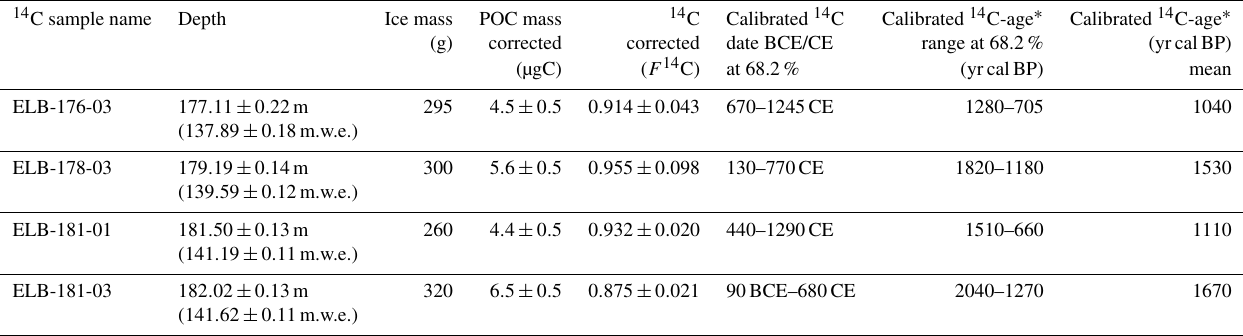
Table 1. Overview of masses (corrected for blanks but not for combustion efficiency) and conventional 14 C ages of the Elbrus ice core samples combusted in the REFILOX system. Calibrated date ranges are shown at 68.2% confidence level and are rounded according to Millard (2014).